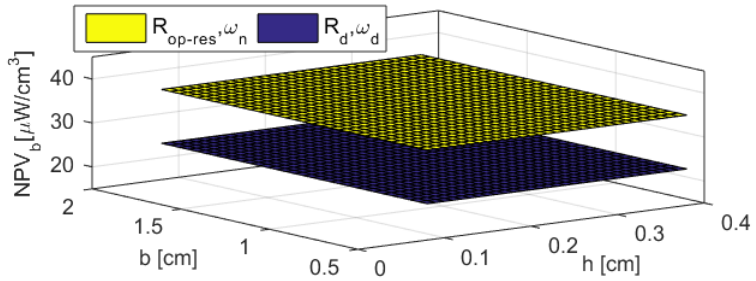
Figure 5. Normalized power to the volume of the beam ( f n constant at 155 Hz, free length varies from 4.41 to 9.62 cm for the corresponding total thickness varies from h = 0.08 to 0.38 cm, respectively, constant mass ratio at β = 0, mechanical damping ratio of ζ m = 0.01, and input displacement of u = 0.8 µm). The normalized power to the volume of the beam and the tip mass (NPV b+mt ) is